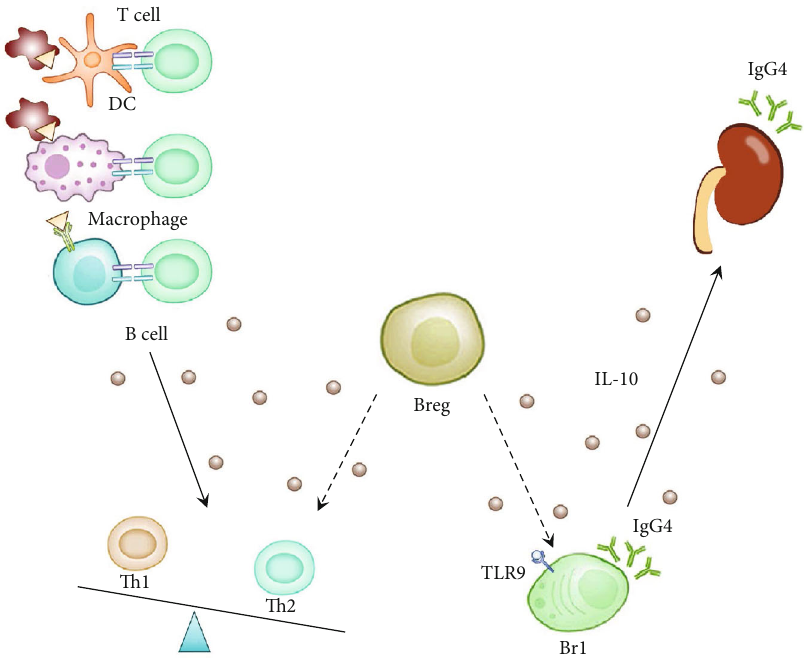
Figure 3: The role of Breg in IMN. Common autoantigens of IMN include PLA2R and THSD7A. Dendritic cells and macrophages phagocytose damaged cells or particles carrying this antigen, or B cells recognize the circulating soluble antigen. These professional APCs capture, process, and present their antigens to Th cells. Th cells reactivate B cells and induce di ff erentiation. In an in vivo high-IL-10 environment, Br1 cells ’ TLR9 is also stimulated. This stimulates the secretion of IgG4 by Br1 cells. This happens even though IgG4 blocks autoantibodies, forming immune complexes beneath the glomerular epithelium, leading to